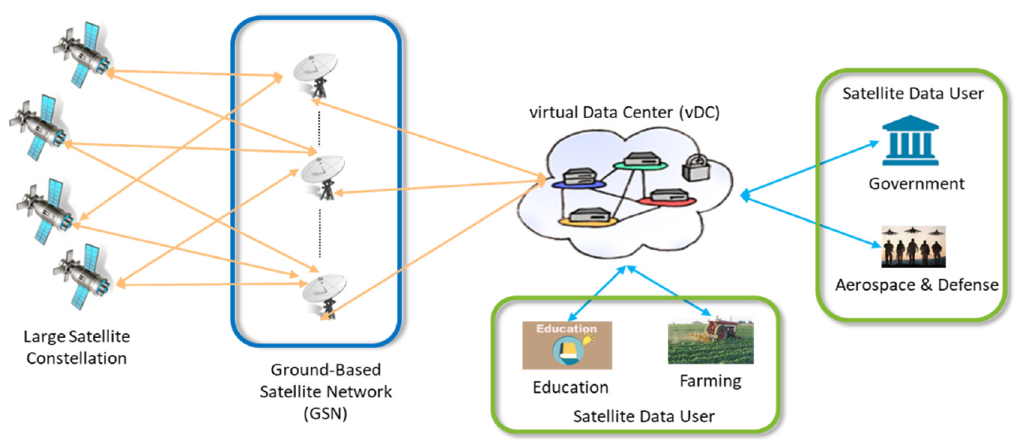
Figure 3. Cloud-Based GSN Service Solution for Large Satellite Constellation.